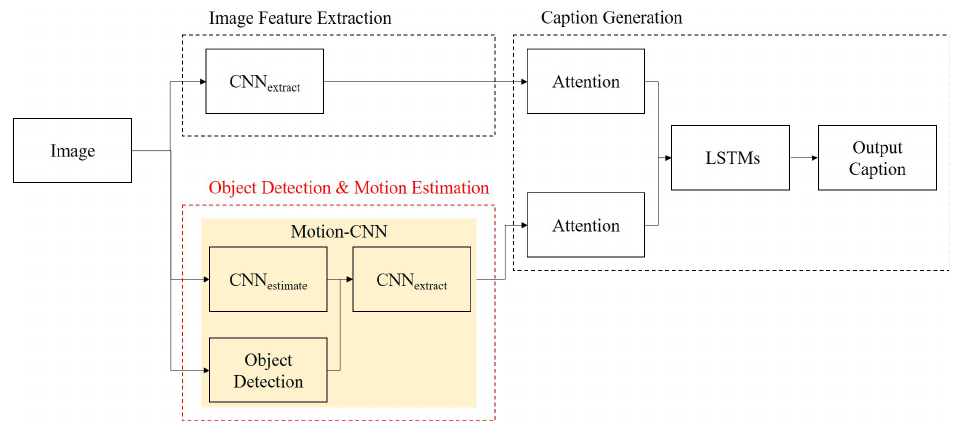
Figure 2. Overview of our proposed model, which comprises CNN extract and motion-CNN, con- sisting of CNN estimate , CNN extract , and object detection. Attentions and long-short term memories (LSTMs) are performed to obtain attention features and captions. The model takes the images and the words estimated at the last time step as